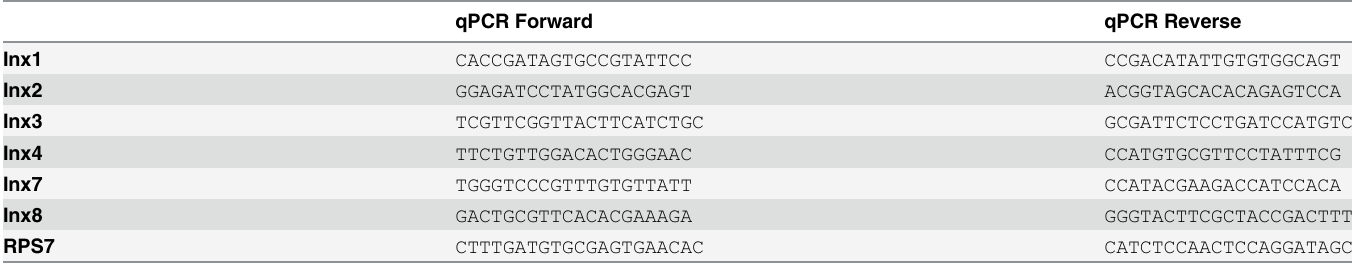
Table 2. qPCR primer pairs. Each set of primers was selected for innexin specificity and determined specific through melt curve analysis and sequencing (MCIC,